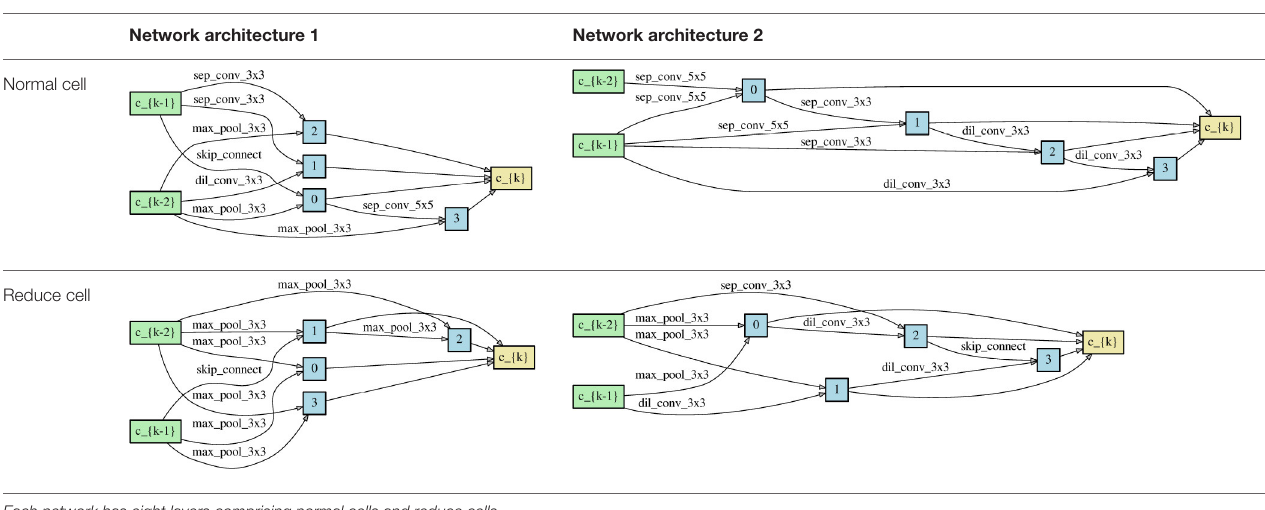
TABLE 2 | Two neural network architectures for the ranking of empirical risk.